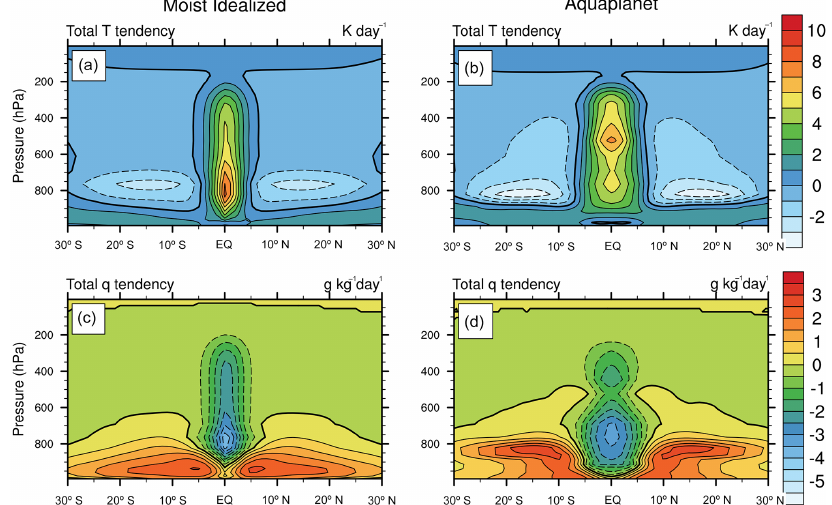
Figure 3. Comparison of CAM5-SE latitude–pressure cross sections in MITC (left column) and APS (right column): Time-mean zonal-mean (a, b) total temperature tendency and (c, d) total specific humidity tendency from the physical parameterization packages. The latitude range is 30 ◦ S to 30 ◦